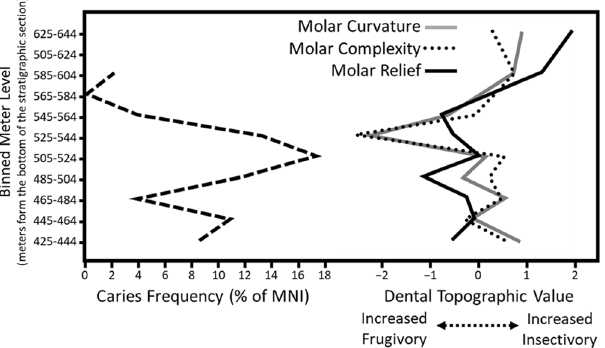
Figure 3. Results of the measurement of caries frequency over time and Z-score transformed results of the dental topographic analysis from Selig et al. 35 . Results are presented as mean values from each 20-m interval (or bin) form the bottom of the stratigraphic section. Note that during the period when caries frequency is highest (17.24% MNI from 505 to 524 m from the bottom of the stratigraphic section), molar curvature and molar complexity decrease (although slightly later from 525 to 544 m from the bottom of the section) suggesting that both dental topography and caries frequency are capturing a similar shift in diet during this period in